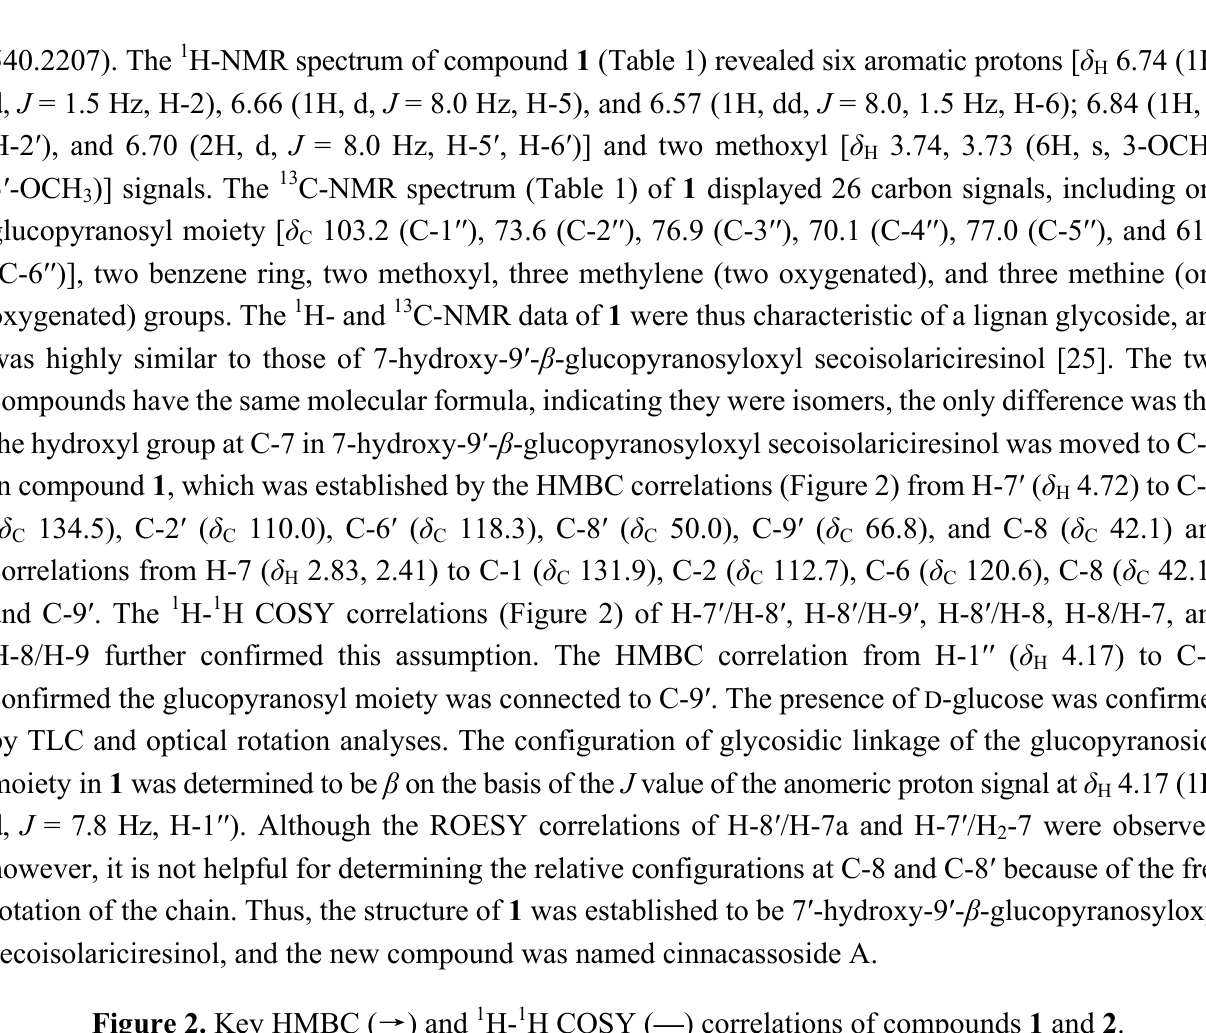
Figure 2. Key HMBC ( → ) and 1 H- 1 H COSY ( — ) correlations of compounds 1 and 2